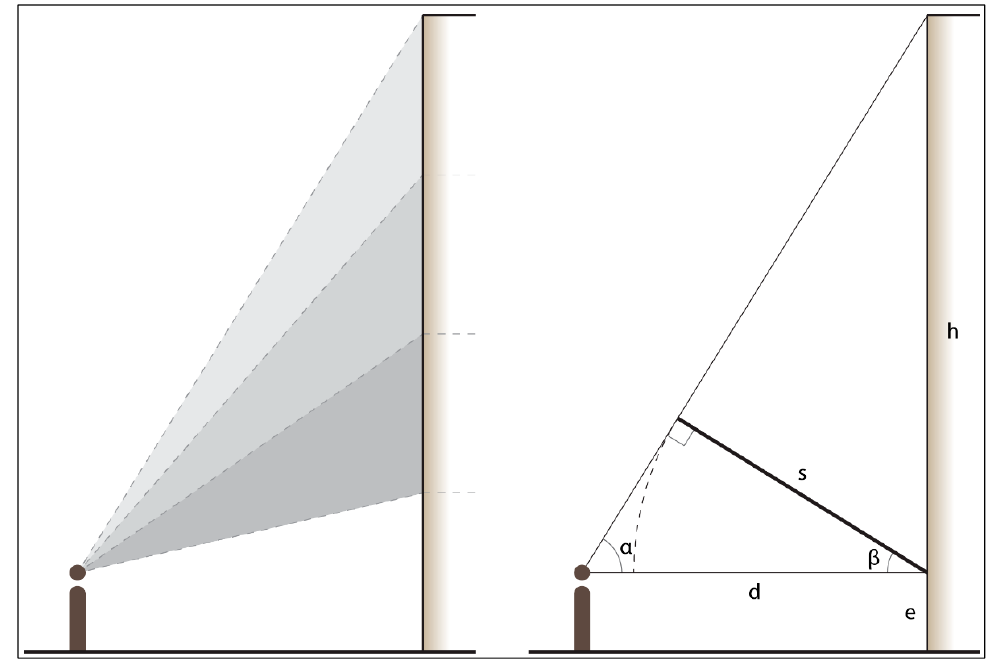
Figure 5. Diminishing occlusion by height (left), occlusion projection calculation (right).